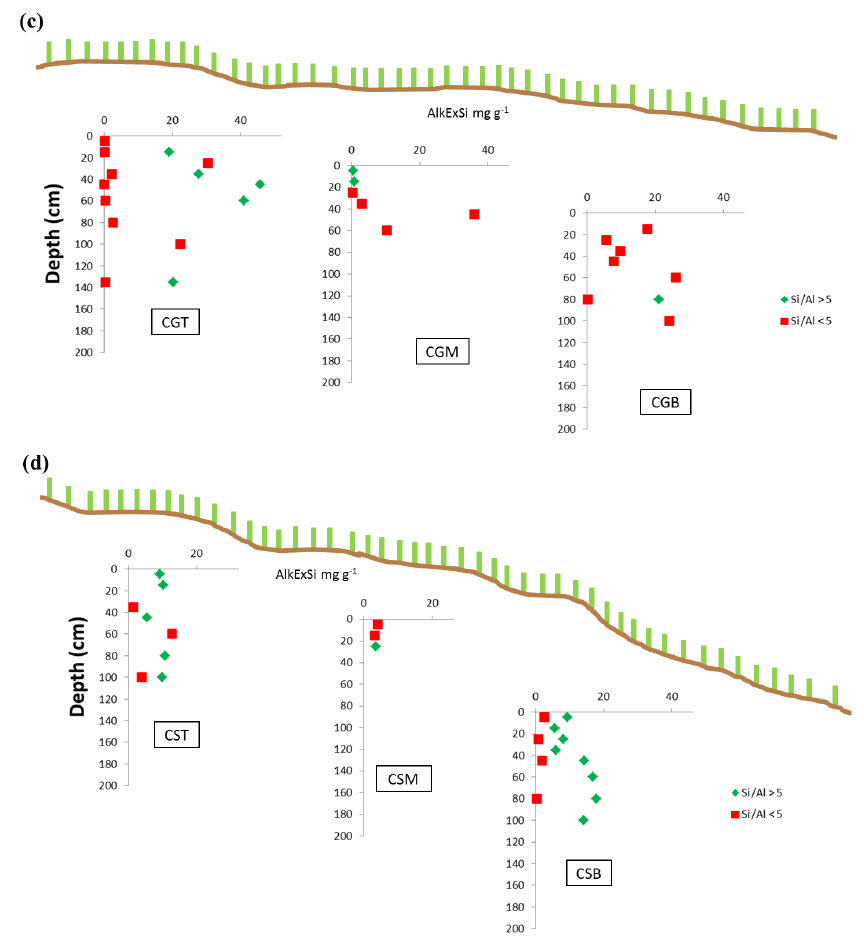
Figure 3. Biogenic and non-biogenic AlkExSi concentrations (mgg − 1 dried soil) from selected pits of the sites studied: (a) gentle slope of the forest, (b) steep slope of the forest, (c) gentle slope of the cropland and (d) steep slope of the cropland. Graphs from left to right: top, upper middle, lower middle (or middle) and bottom